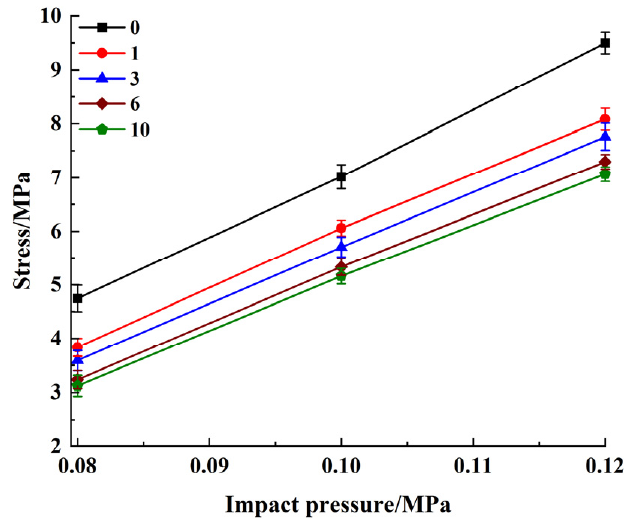
Figure 9. Effect of impact pressure on strength.